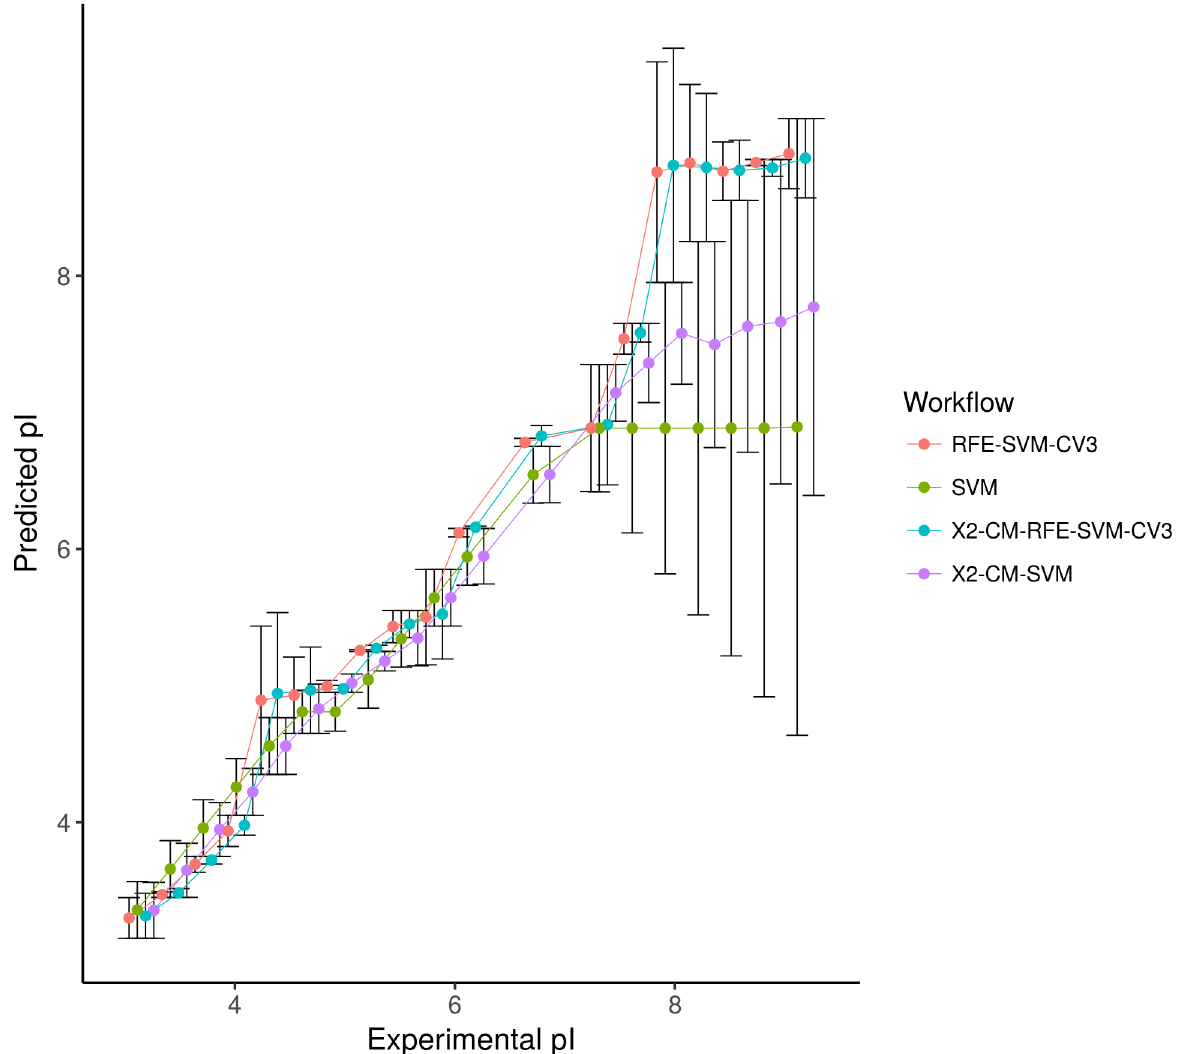
Fig 4. Error plot of predicted isoelectric point vs the experimental isoelectric point (Dataset2): (SVM) applying FS or cross- correlation step; (X2-CM-SVM) adding correlation filters as the only steps for feature selection; (RFE-SVM-CV3) recursive feature elimination, three interactions of cross-validation combined with SVM; (X2-CM-RFE-SVM-CV3) considering the full FS workflow.